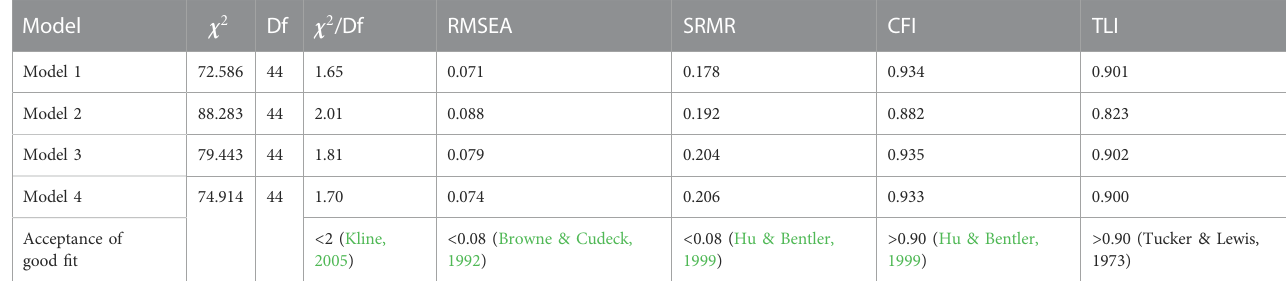
TABLE 4 Model fi t